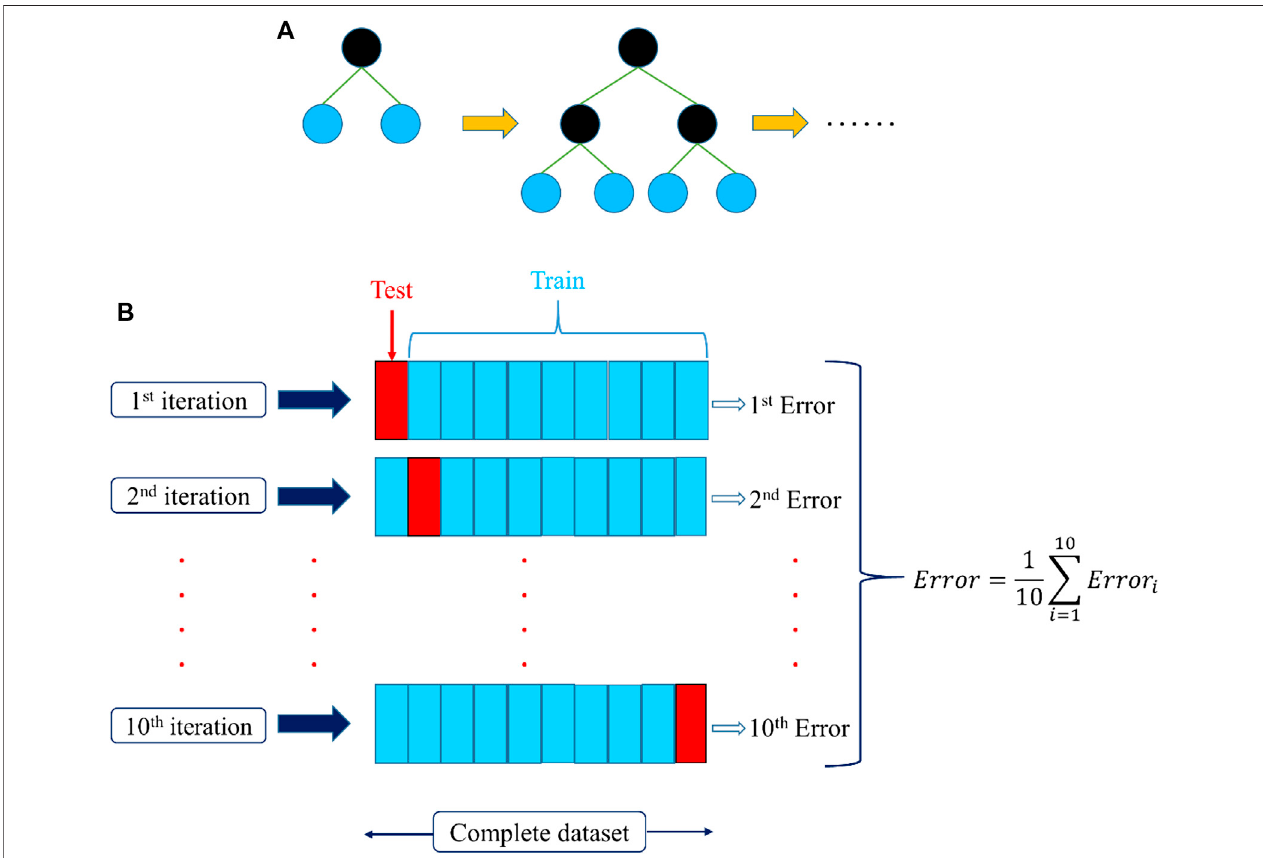
FIGURE 5 | (A) Basic structure of the level-wise XGBoost tree model. (B) Grid search cross validation.